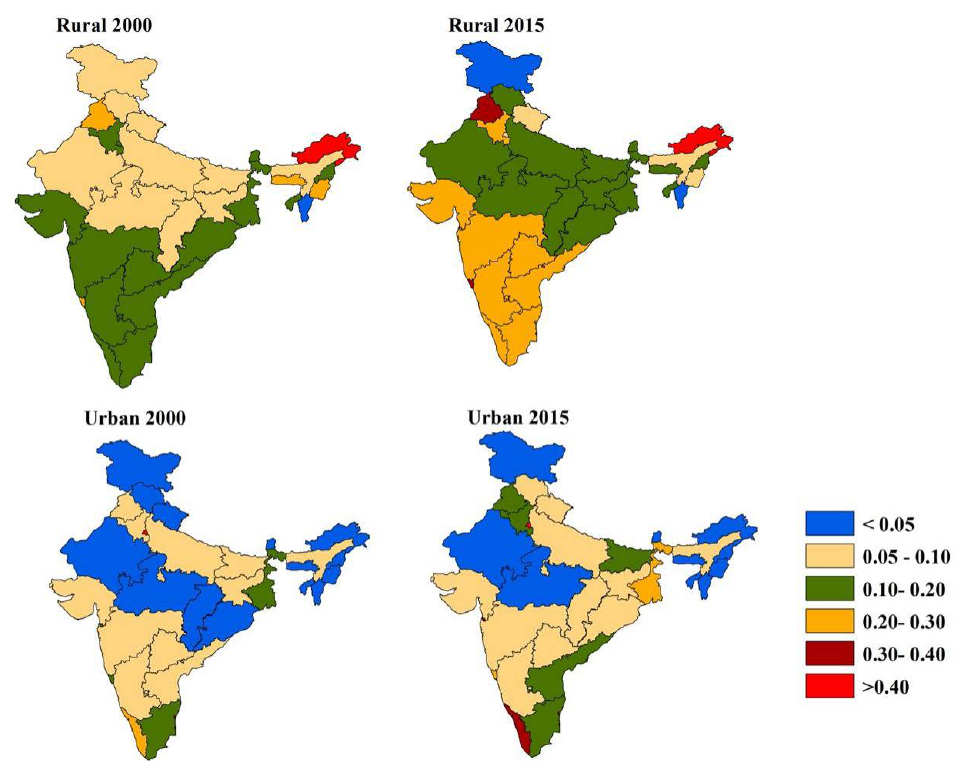
Figure A7. Regression statistics of the satellite-based daily PM 2.5 with measurements from CPCB sites for the various geographic regions (shown in the bottom right panel) over India. There are no ground- based monitoring sites in Northeast and North India to validate the retrieved PM 2.5.